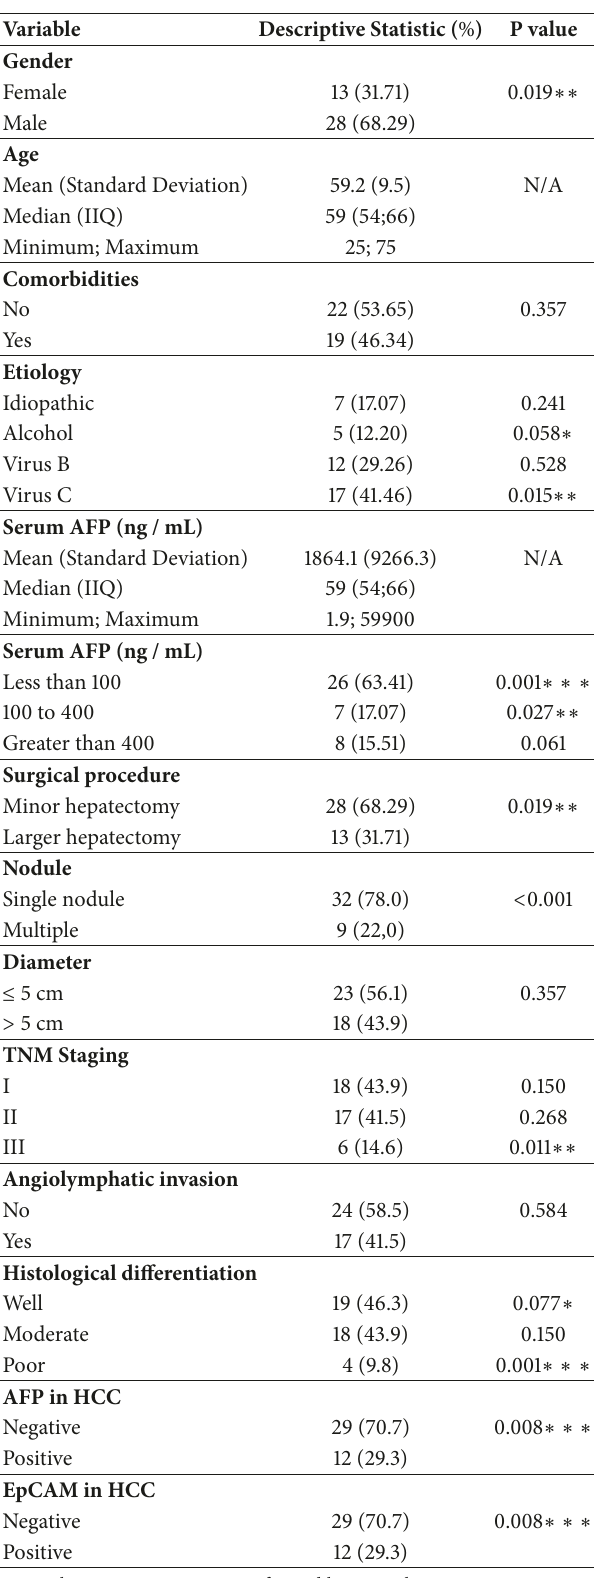
Table 1: Demographic and clinicopathological characteristics in patients with hepatocellular